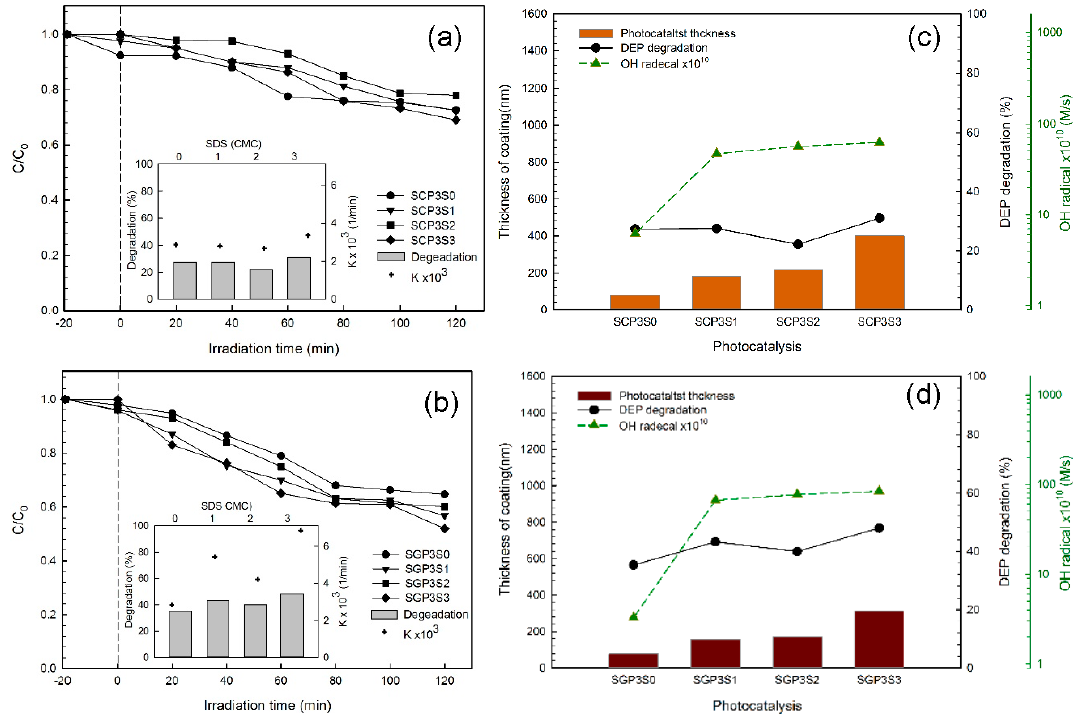
Figure 7. ( a , b ) Photodegradation of diethyl phthalate (DEP) by sol-gel hydrolysis photocatalysts ([DEP] 0 = 1 mg/L; pH = 7; λ = 410 nm; I = 40 mW/cm 2 ; Irradiation time = 120 min); ( c , d ) Photodegradation efficiency of DEP by sol-gel hydrolysis photocatalysts vs. hydroxyl radical generation and coating film thickness.